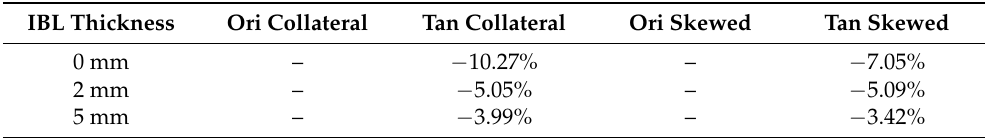
Table 4. The static pressure rise coefficient difference between the tandem cascade and the original cascade. IBL Thickness Ori